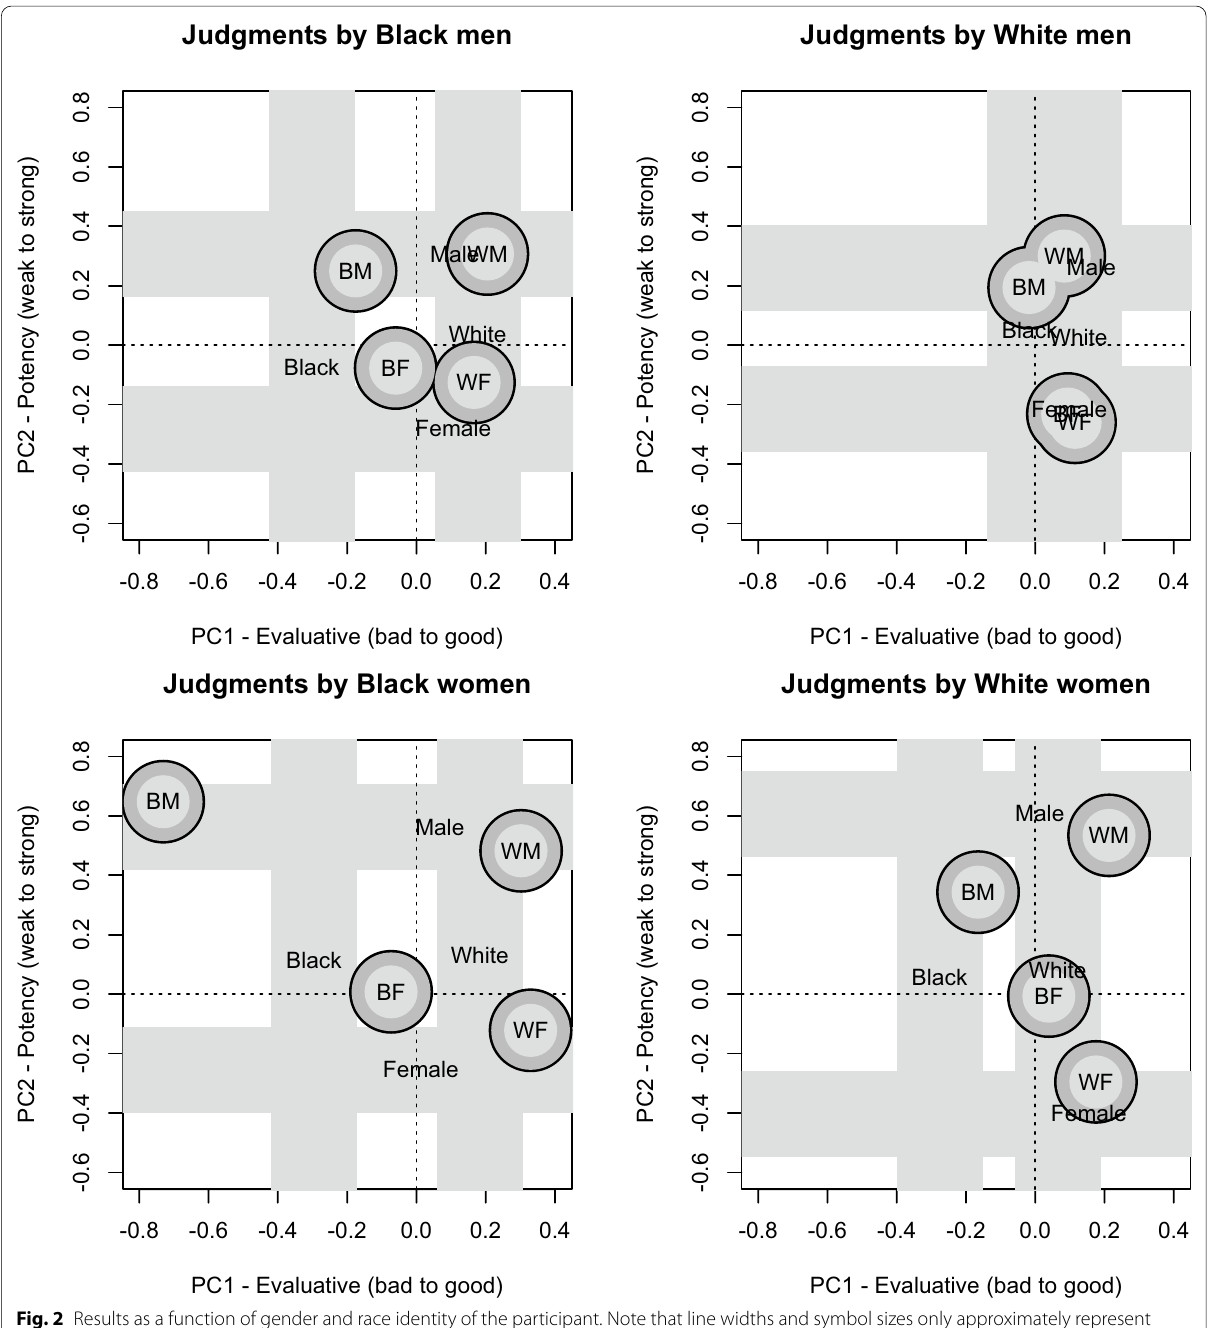
Fig. 2 Results as a function of gender and race identity of the participant. Note that line widths and symbol sizes only approximately represent variability (two times the standard errors of the means). The zero point in each plot represents the mean scores for the cases where neither race nor gender was